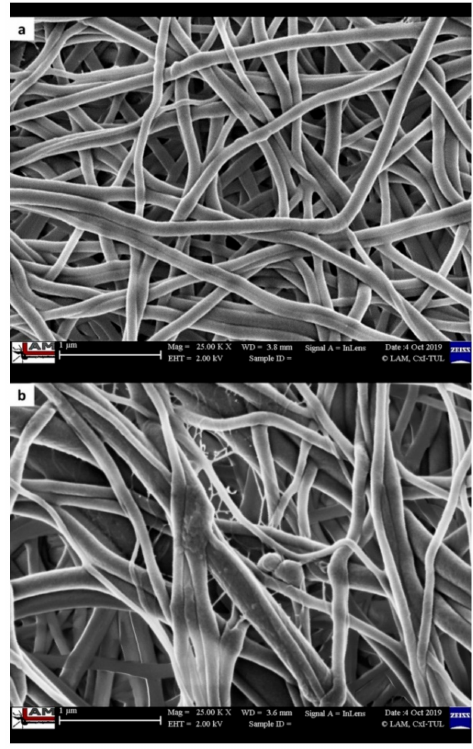
Figure 1. Comparison of pristine polyamide 6 / polyethylenimine (PA / PEI) nanofibers ( a ) and PA / PEI with immobilized T. versicolor laccase ( b ).